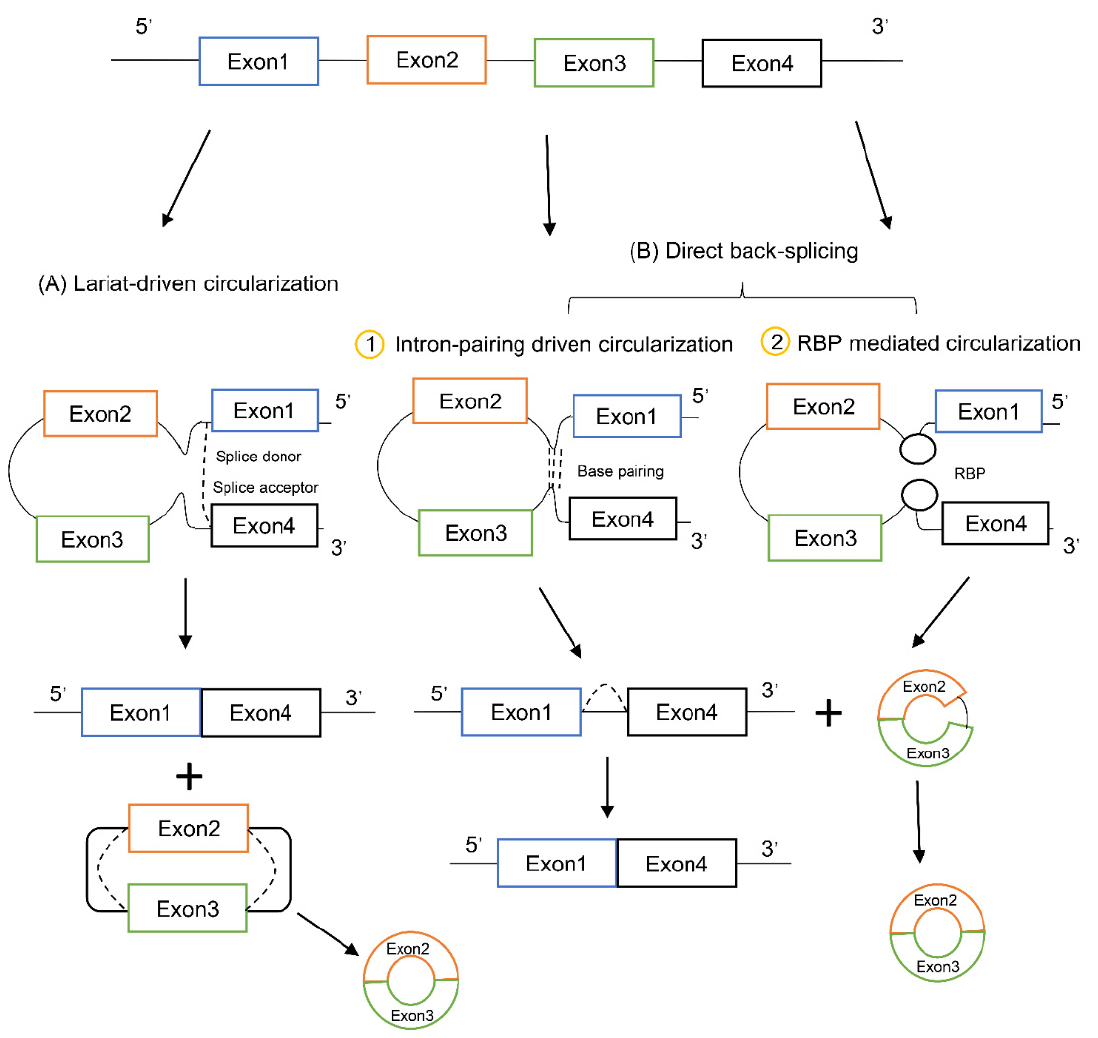
Figure 1. Biogenesis of circRNA. ( A ) Canonical splicing occurs first, exon skipping forms an mRNA composed of exons 1 and 4, and a lariat structure composed of exons 2 and 3, and then back-splicing produces circRNA. ( B ) Back-splicing occurs first, circRNA containing exons and introns is generated through back-splicing, and then further processed to generate linear mRNA. It can be divided into two types, one is (1) “intron-pairing driven circularization”, the complementary sequences of the flanking introns pair with each other to bring the splice sites closer to promote circularization, and the other is (2) “RBP mediated circularization”, RBP interacts with the intron binding sites to make the splice sites closer to induce circularization.